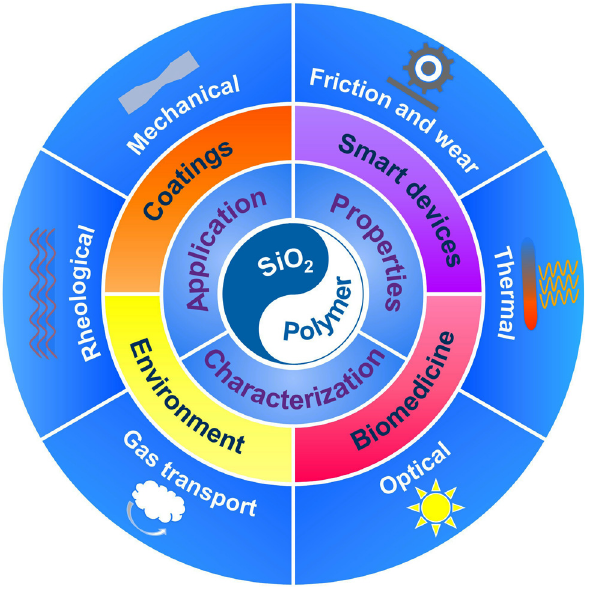
Figure 1: Properties and applications of SiO 2 /polymer